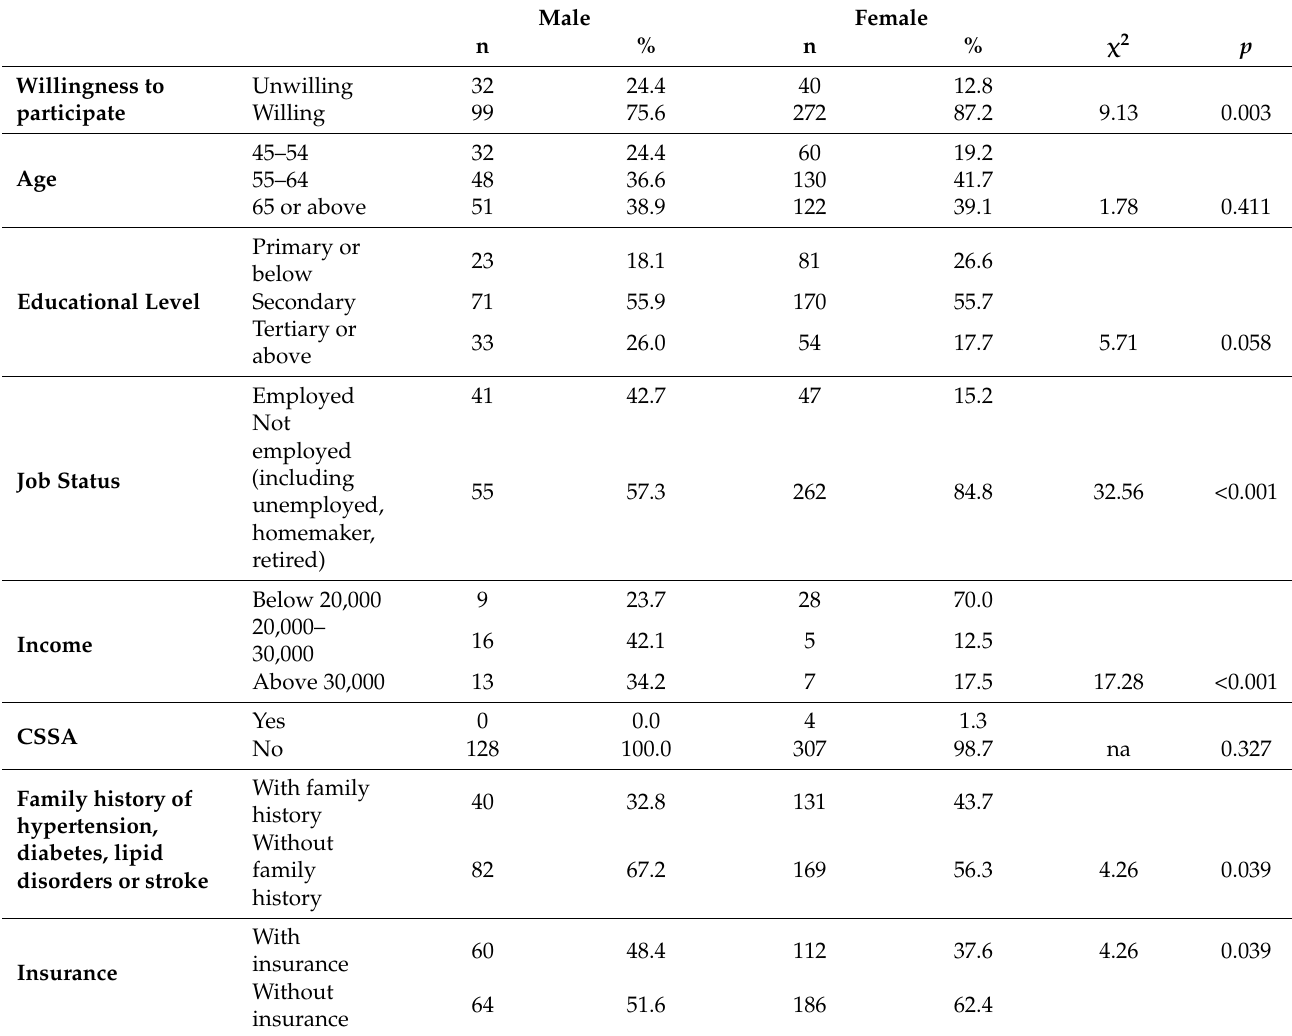
Table 6. Sex-specific willingness of participation in voucher scheme for